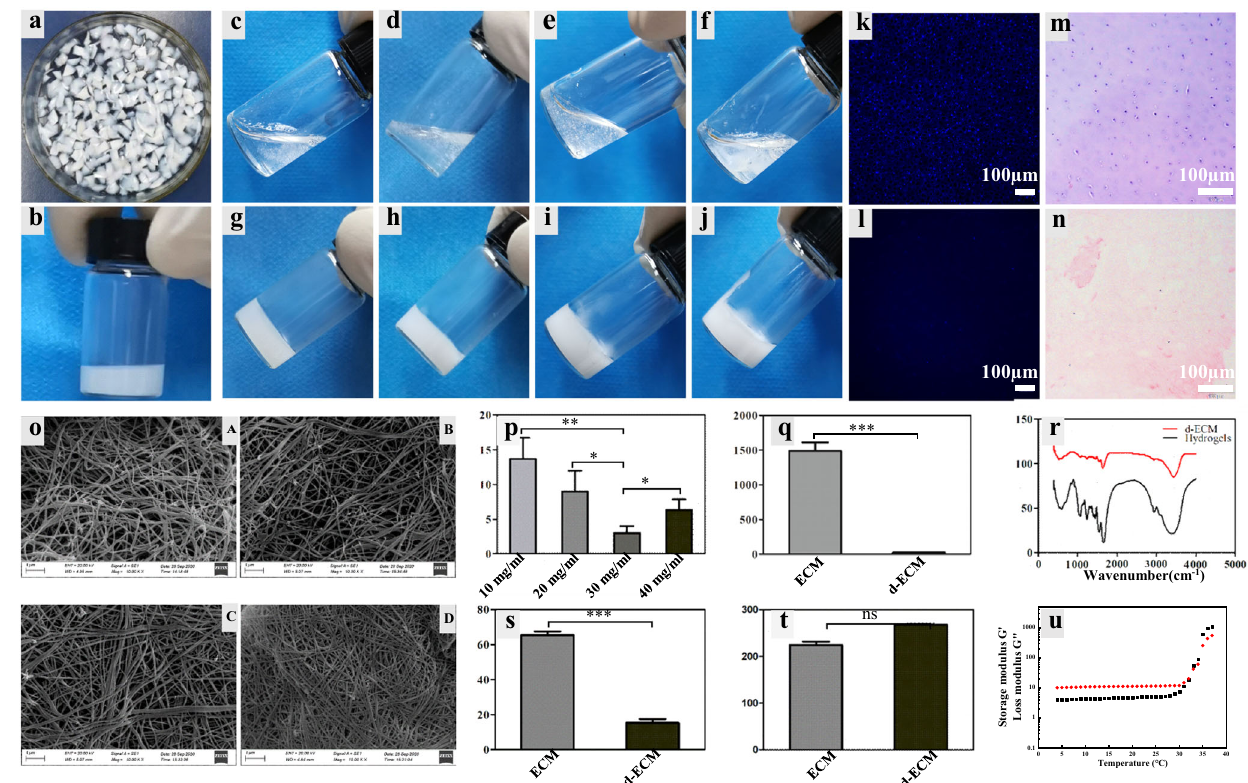
Fig. 3 Characterization of the dECM hydrogel. a Gross appearance of the articular cartilage derived from the pig knee joint. b Representative images of the dECM hydrogels. c – f Various concentrations (10, 20, 30, 40 mg/mL, respectively) of the dECM hydrogels at 4 °C. g – j Various concentrations of the dECM hydrogels (10, 20, 30, 40 mg/mL, respectively) at 37 °C. k , l Representative images of articular cartilage characterization pre- and post-decellularization by DAPI staining. m , n Representative images of articular cartilage characterization pre- and post-decellularization by H&E staining. Scale bar = 100 μ m. h Representative images of the dECM hydrogels (20×). Scale bar = 100 μ m. o SEM images of various concentrations (10, 20, 30, and 40 mg/mL) of the dECM hydrogels. q DNA content in the ECM and dECM, which con fi rmed successful decellularization. r FTIR spectroscopy of the decellularized ECM (d-ECM) and dECM hydrogels. s , t GAG and Collagen II (COL-II) concentration of the ECM and dECM. u Rheological behavior of the dECM hydrogels. ns, not signi fi cant; * P < 0.05, ** P < 0.01, *** P < 0.001, * is the statistical difference compare with ECM group. One-way ANOVA followed by the Tukey post hoc test was used. Each data point represents average ± standard deviation, n =